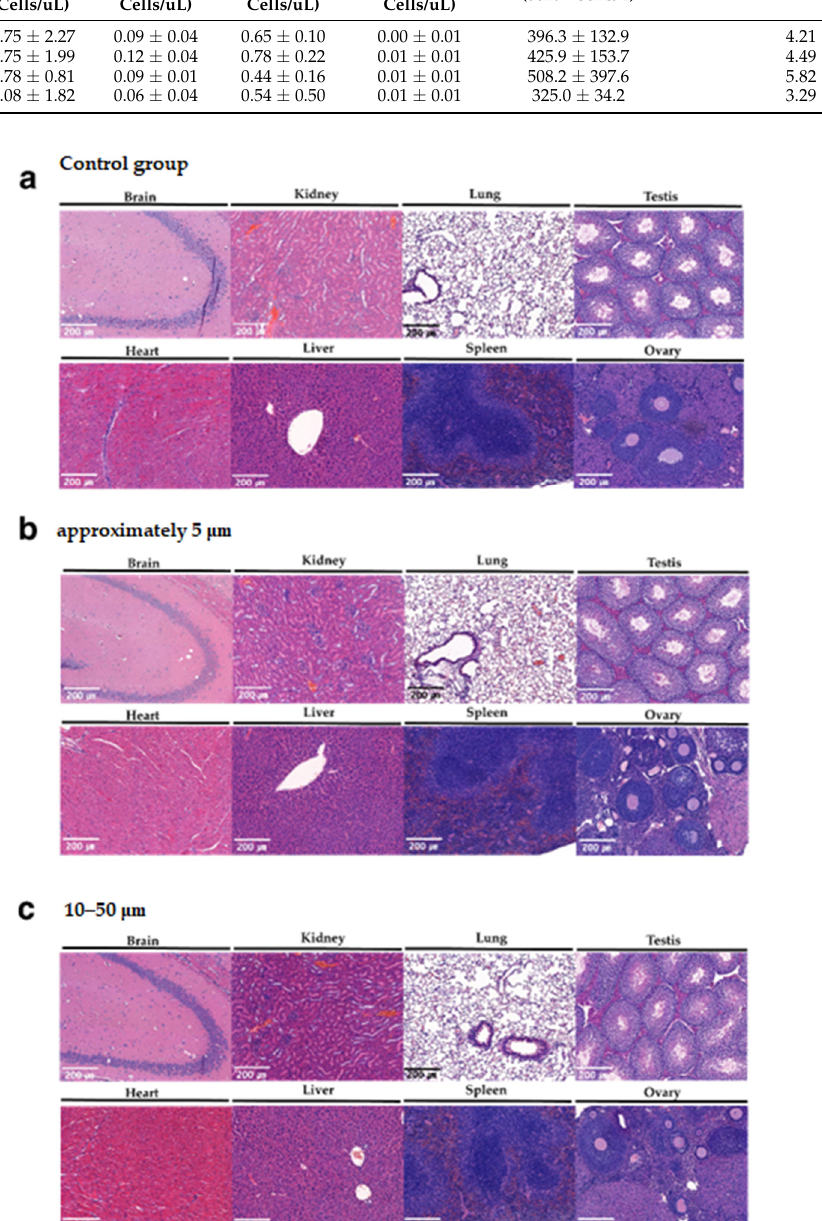
Figure 5. Histopathological evaluation of tissues from mice after four weeks of repeated dosing. Representative images of the brain (hippocampus), heart, kidney, liver, lung, spleen, testis, and ovary of the control mice ( a ), approximately 5 μm PTFE-treated mice ( b ) and 10‒50 μm PTFE-treated mice ( c ). Scale bar = 200 μm.